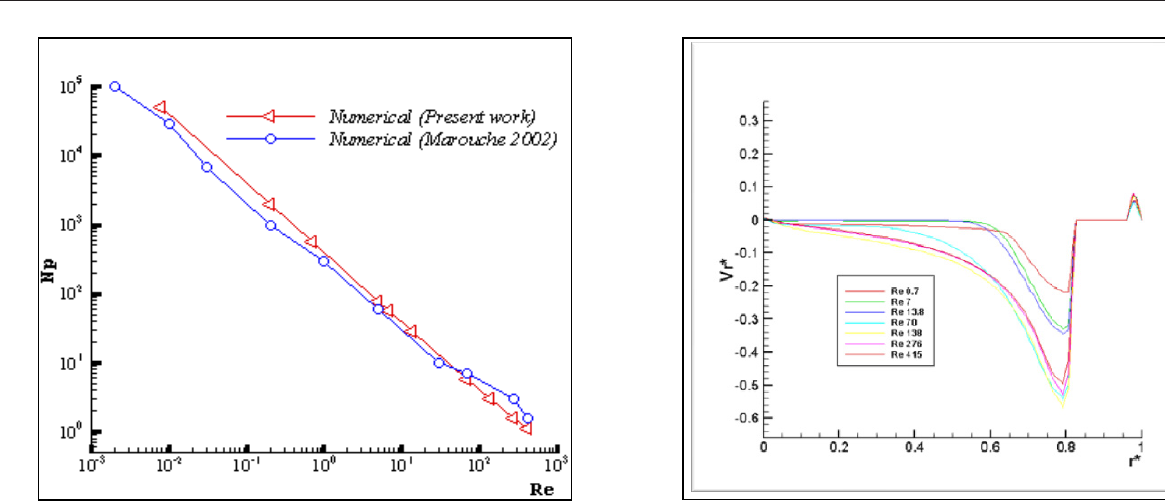
Fig. 5. Influence of inertia on the tangential velocity at the mediator.